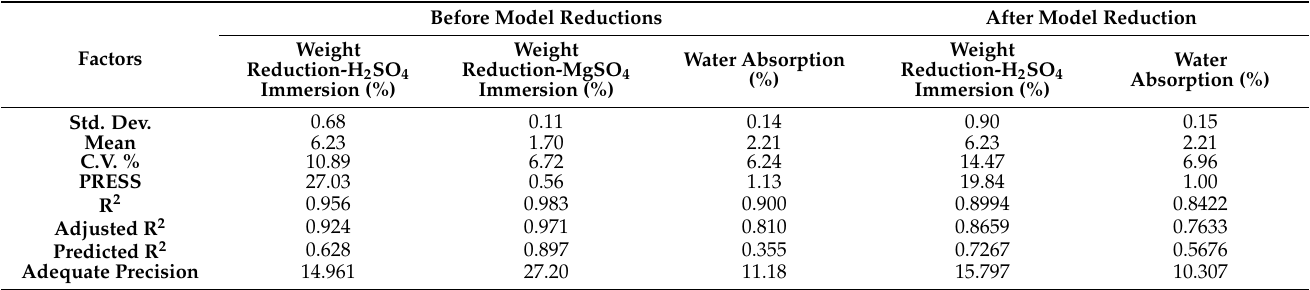
Table 5. Coefficient of determination for durability